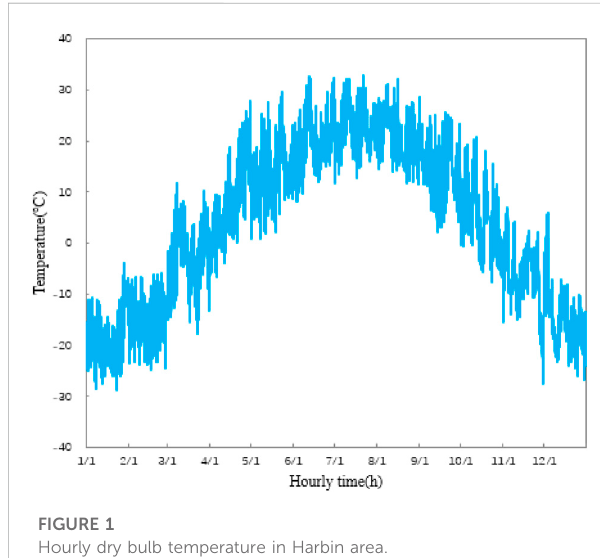
FIGURE 1 Hourly dry bulb temperature in Harbin